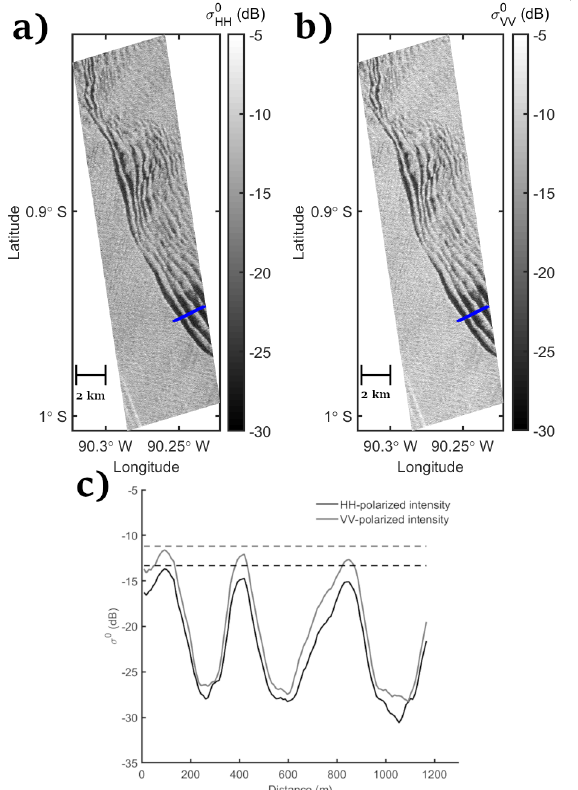
Figure 1. L-band ALOS-PALSAR image acquired on 2009.03.14 showing an example of an internal wave (IW) near Galapagos Island. ( a ) HH-polarized intensity channel (i.e., σ 0 ) image, ( b ) VV-polarized HH intensity channel (i.e., σ 0 ) image, where the blue line represents the selected IW profile; and VV ( c ) IW profile associated to HH- and VV-polarized intensity channels, where the black and gray dashed lines correspond to the mean value of the background associated to, respectively, HH- and VV-polarized